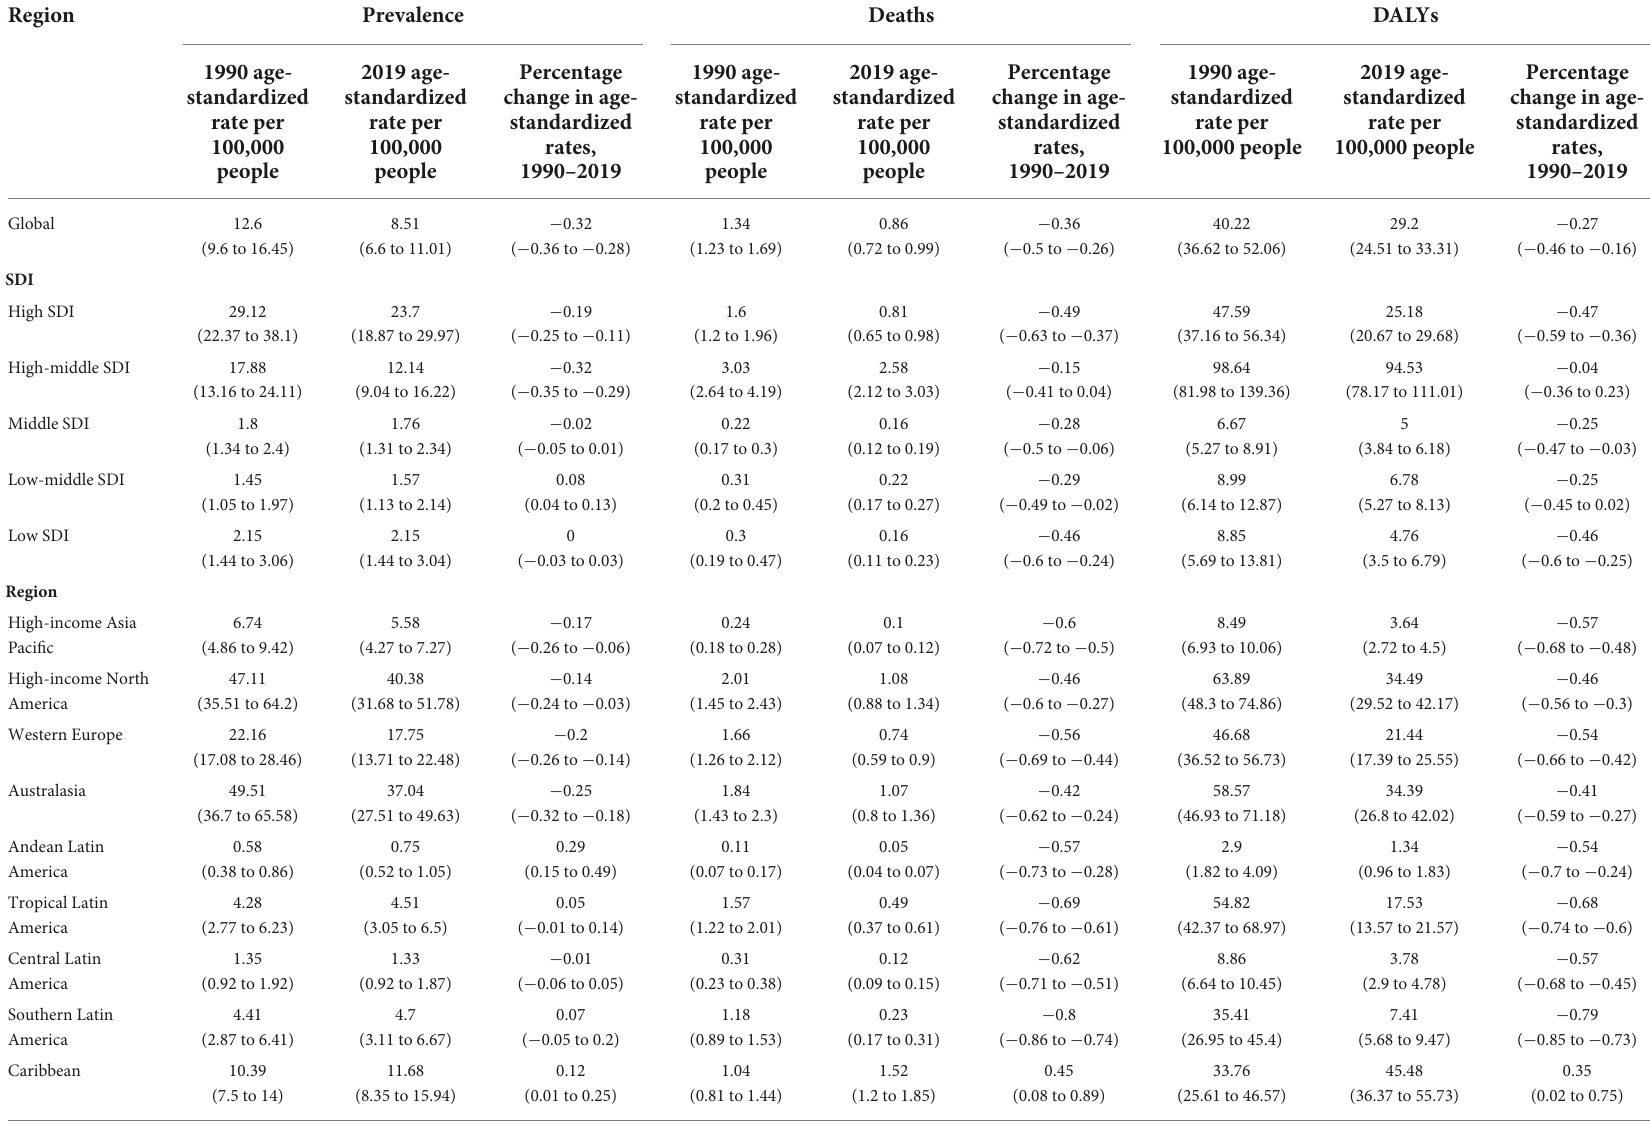
TABLE 2 Age-standardized prevalence, death, DALYs rates of the alcoholic cardiomyopathy, and their percentage changes with 95% UIs from 1990 to 2019, both sexes.